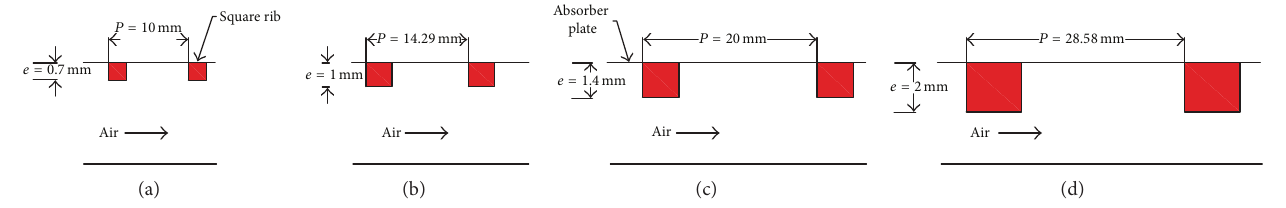
Figure 2: Roughened absorber plate with different configuration of square-sectioned transverse